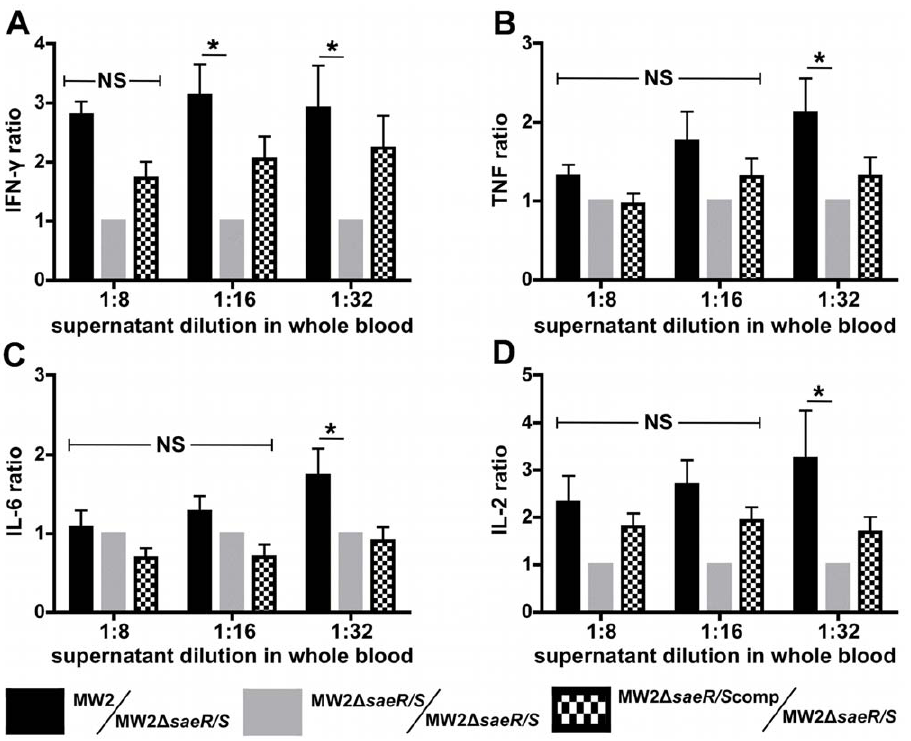
Figure 3. Secreted factors influenced by saeR/S promote inflammatory cytokines in human whole blood. S. aureus supernatants were collected at early stationary growth phase. Human whole blood was exposed to diluted S. aureus supernatants from MW2, MW2 D saeR/ S and MW2 D saeR/ Scomp strains. Cytokine levels were measured after 3 hours. Results represent the blood plasma concentration ratios of ( A ) IFN- c , ( B ) TNF, ( C ) IL-6 and ( D ) IL-2. Ratios represent the concentration of protein measured in MW2, MW2 D saeR/S or MW2 D saeR/S comp-treated whole blood to the concentration measured in MW2 D saeR/S -treated blood, normalized for each donor. Protein concentrations were measured by cytometric bead array. Results are from 4 separate donors. * P , 0.05 versus MW2 as measured by ANOVA with Tukey’s post-test. NS=not significant.